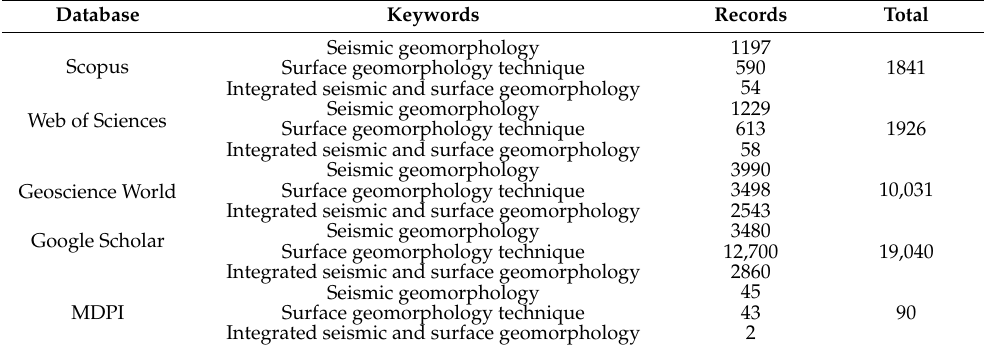
Table 1. Summary of seismic and surface geomorphology research papers used in this review with the source of